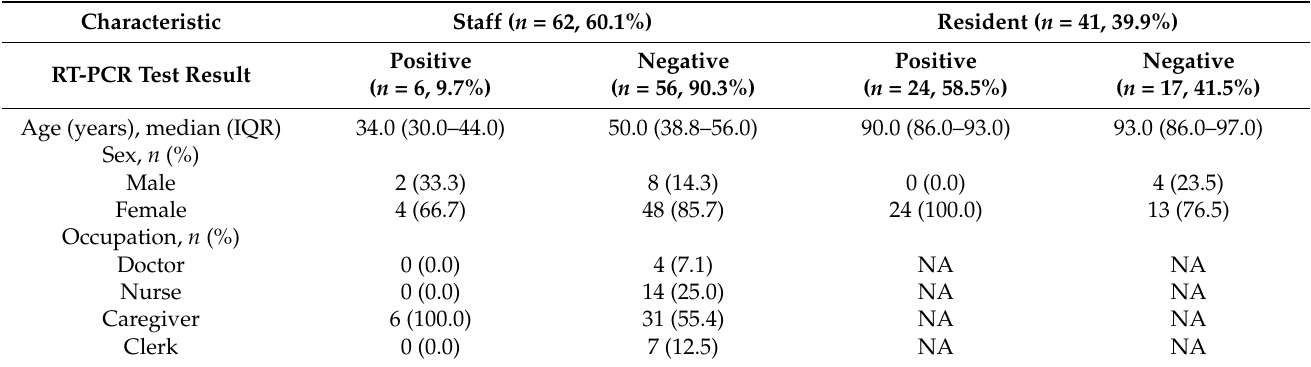
Table 1. Epidemiological characteristics of the study population ( n =